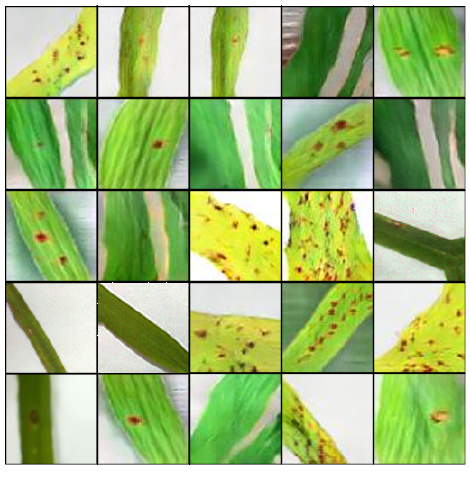
Figure 11. Comparison of generated samples.